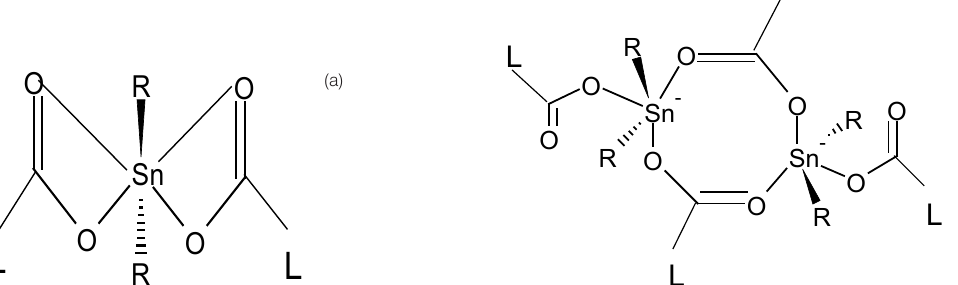
Figure 4. Geometrical trends in diorganotin(IV) complexes (a) trans-octahedral (R =Me, Et, Pr, Bu; (b) skew trapezoidal (R =Ph).